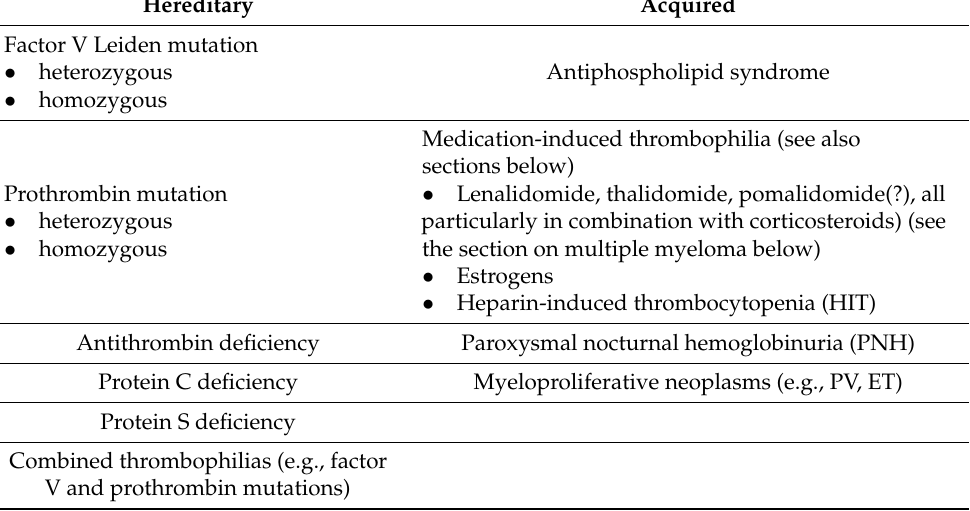
Table 4. Types of thrombophilia